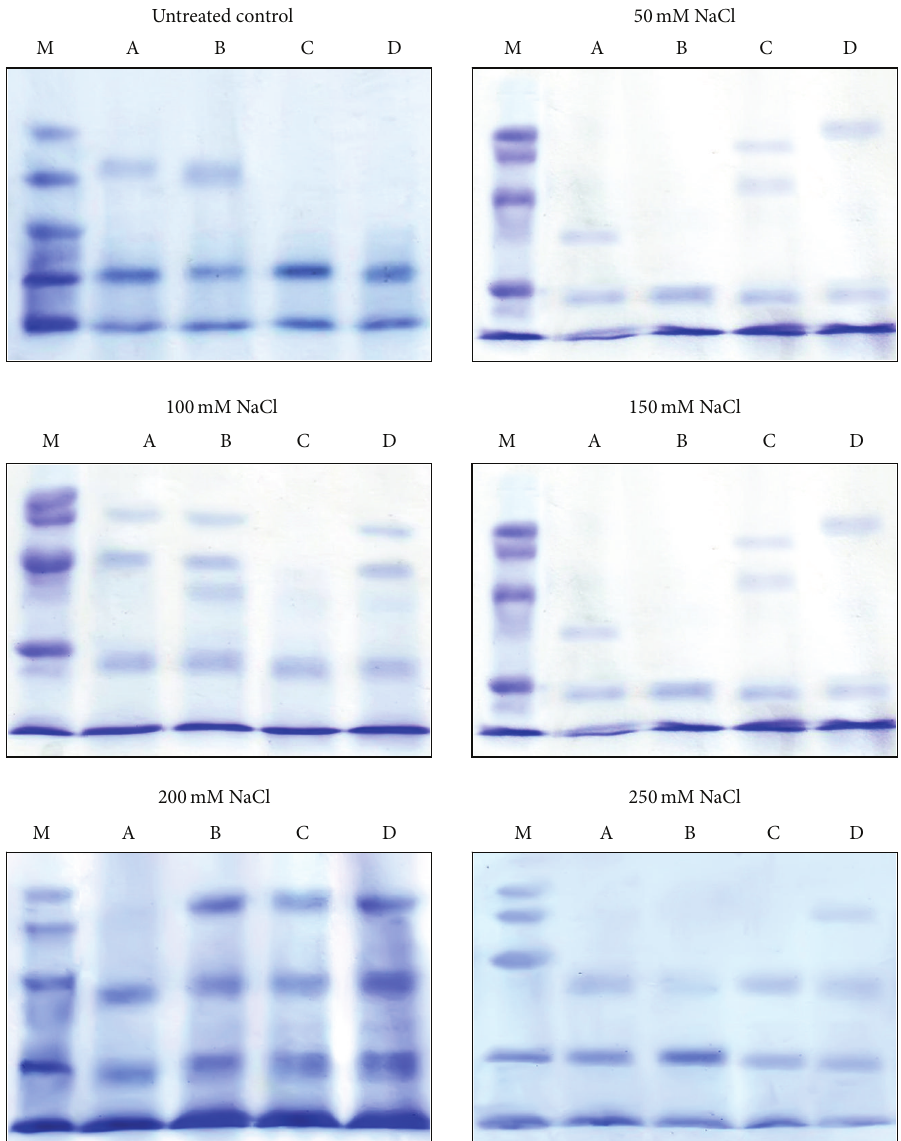
Figure 6: SDS-PAGE protein profile of salinity stressed Triticum aestivum seedlings presoaked in distilled water (A), 1% U. lactuca extract (B), 5% U. lactuca extract (C), and 10% U. lactuca extract (D). Protein markers